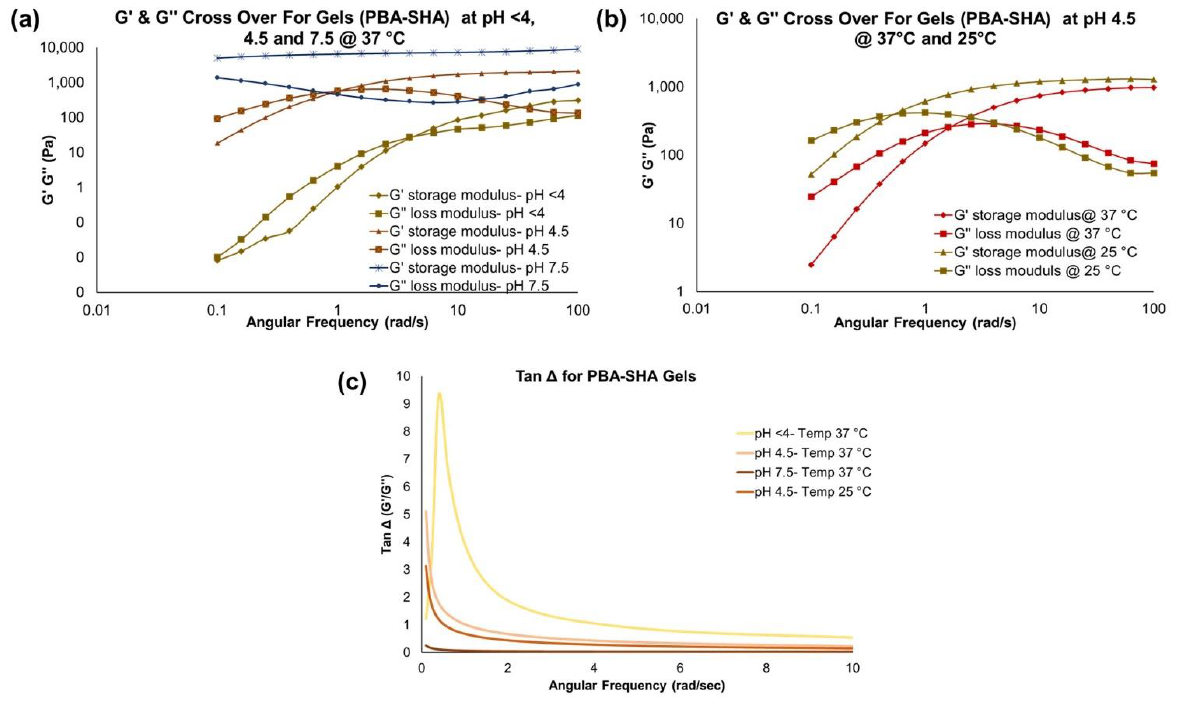
Figure 2. PBA-SHA gel rheology data: ( a ) pH-dependent (at <4, 4.5, and 7.5) and ( b ) temperature- dependent (at 25 and 37 °C) changes in the G′ and G″ modulus profiles at varying angular frequency. ( c ) Tan Δ plots confirming both temperature and pH affected the viscoelastic strength of the gel. Table 1. Concentrations of C i and PBA-functionalized polymers, rheological characterizations, and physical observations of C i -PBA gels. The G (cid:48) max and G (cid:48)(cid:48) max values were measured at 25 ◦ C and marked as maximum values obtained for the scans in the range of 1 to 10